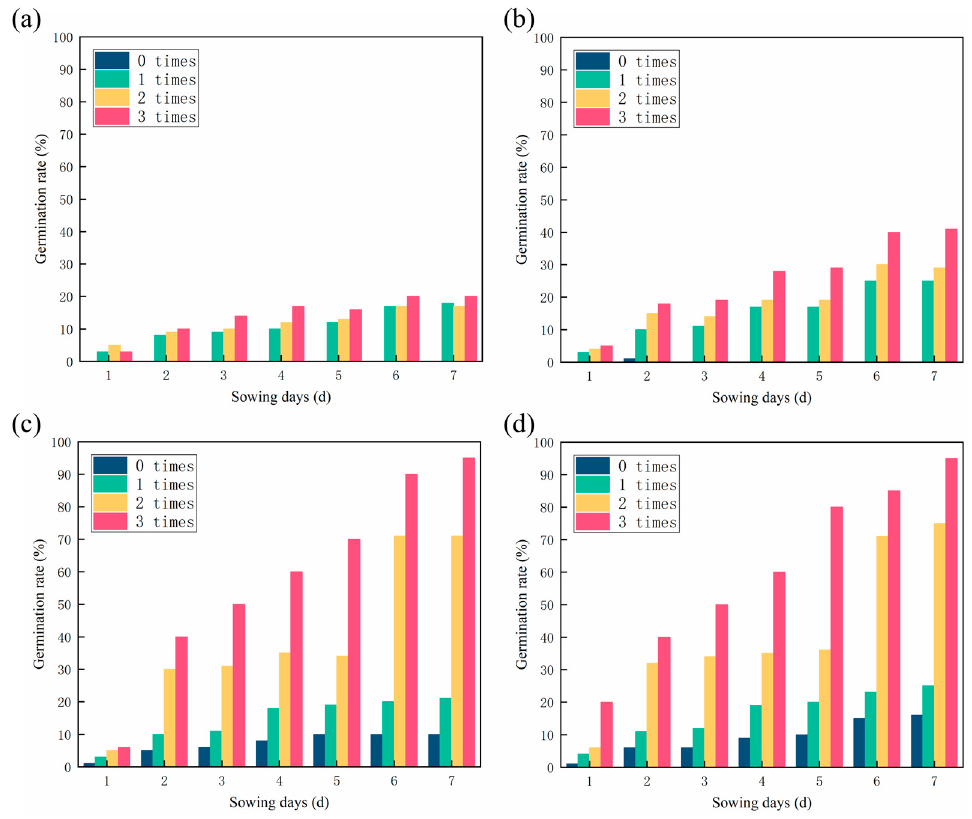
Figure 5. Effects of irrigation times and treatment methods on the germination rate of sandy soil: ( a ) Blank; ( b ) CSF; ( c ) BSF; and ( d ) BAC.